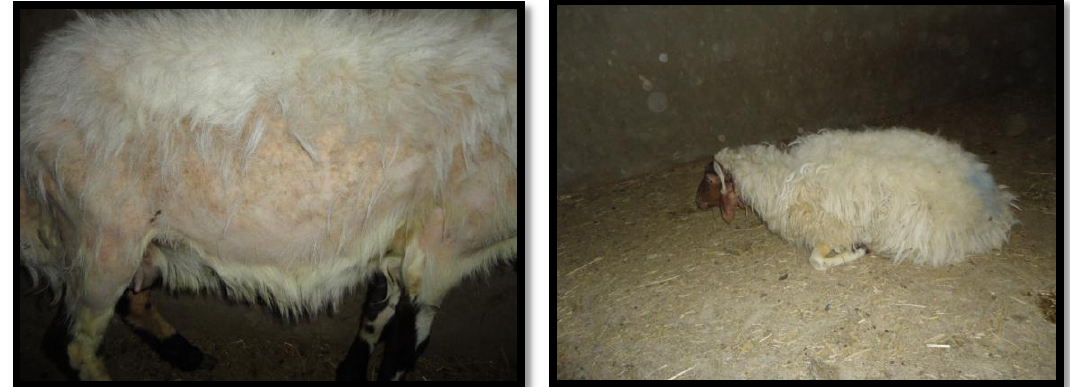
Figure (7) shows loss of body weight and loss of wool Figure (8) shows weakness, dullness and